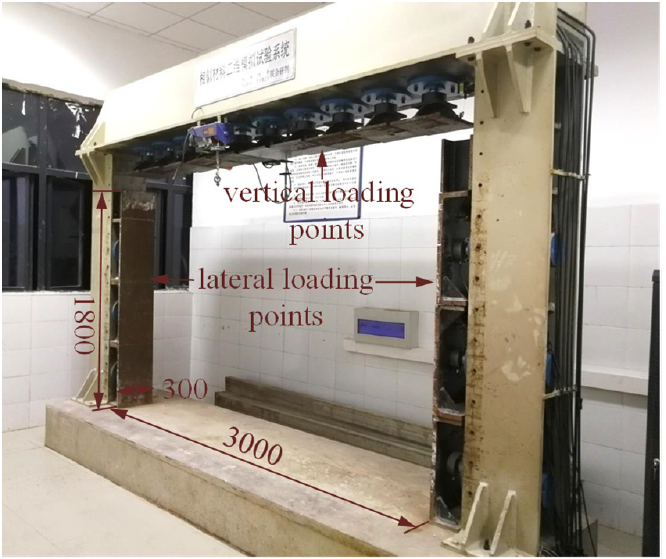
Figure 3. QKX ‐ EW ‐ 2 two ‐ dimensional physical similarity simulation test bench. Figure 3. QKX-EW-2 two-dimensional physical similarity simulation test